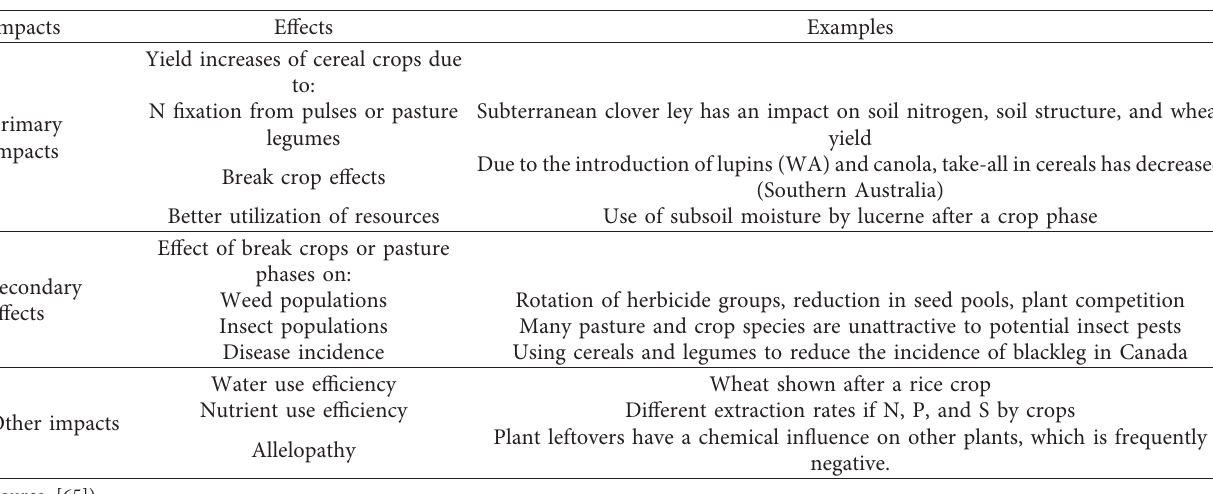
Table 2: Agronomic impacts of crop